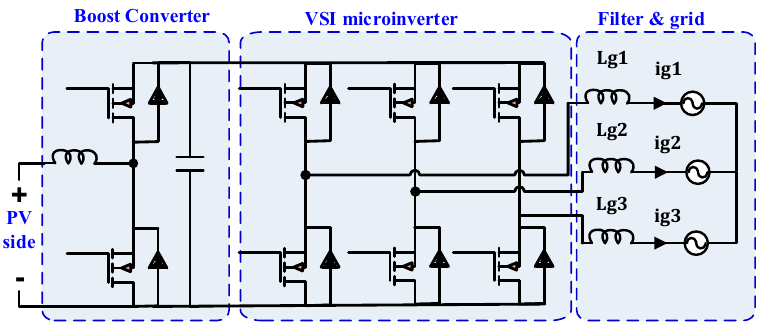
Figure 20. Two-stage three-phase microinverter proposed by Jain and Singh [108].